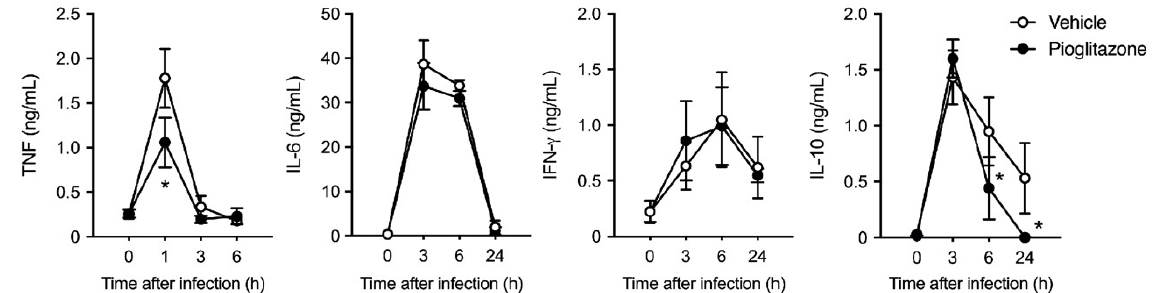
Figure 2. Pioglitazone attenuates systemic inflammatory responses in post-burn-infected mice. Tumor necrosis factor (TNF), interleukin (IL)-6, interferon (IFN)- γ , and IL-10 levels were measured using enzyme-linked immunosorbent assay (ELISA) in serum samples collected at the indicated time points after bacterial infection. n = 8 per group; pooled data of two independent experiments. Data are represented as the mean ± SD; * p < 0.05 vs.